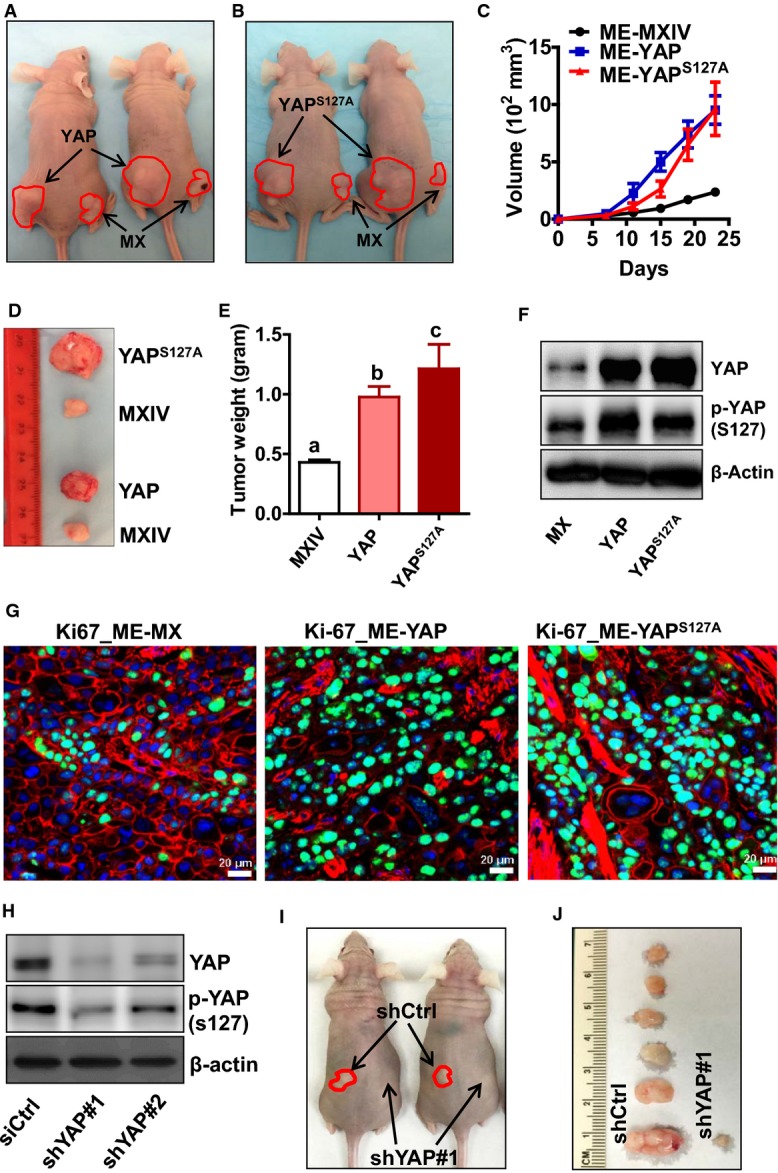
Effect of YAP on human cervical tumor growth in vivo
A, B Representative images of tumor xenografts of ME180-MXIV (MX, right flank), ME180-YAP (A) (YAP, left flank), and ME180-YAPS127A (B) (YAPS127A, left flank) cells implanted in athymic nude mice. Red lines indicate the edge of tumors.

C The growth curve of human tumor xenografts derived from control (ME-MX) and YAP-overexpressing ME180 cervical cancer cell lines (ME-YAP, ME-YAPS127A) implanted in the athymic nude mice. Each point represents mean ± SEM of six tumors (control n = 10).

D Representative images showing the relative size of tumors from control and YAP-overexpressing ME180 cervical cancer cells.

E The average weight of tumor xenografts from the control and YAP-overexpressing ME180 cell lines. Data were analyzed for significance using one-way ANOVA in GraphPad Prism 5 with Tukey’s post hoc tests. Each bar represents the mean ± SEM (n = 10 for control, n = 6 for YAP and YAPS127A groups). Bars with different letters are significantly different from each other (MXIV vs. YAP, P = 0.0008; MXIV vs. YAPS127A, P < 0.0001).

F Western blot analysis of YAP protein levels in the tumor xenografts derived from ME180-MXIV, ME180-YAP, and ME180-YAPS127A cells.

G Expression of Ki67 in the tumor xenografts of ME180-MXIV, ME180-YAP, and ME180-YAPS127A cells implanted in athymic nude mice. Ki67 was visualized using an Alexa-488 (green)-conjugated secondary antibody. Actin was visualized using an Alexa-594 (red)-conjugated secondary antibody. Nuclei were stained with DAPI. Scale bar: 20 μm. Note the significant increase in the Ki67-positive cells in the ME180-YAP and ME180-YAPS127A tumor xenografts.

H Western blot analysis showing YAP protein levels in ME180 cells transfected with lentiviral empty vector (shCtrl) or lentivirus-based YAP shRNAs (shYAP#1 or shYAP#2).

I Representative images showing tumor xenografts derived from ME180-shCtrl cells (left flank) and ME180-shYAP#1 cells (right flank) (n = 6).

J Representative images showing the relative size of tumors derived from ME180 cervical cancer cells transfected with control shRNA (left, shCtrl) or YAP shRNA#1 (right, shYAP#1) (n = 6).
Source data are available online for this figure.